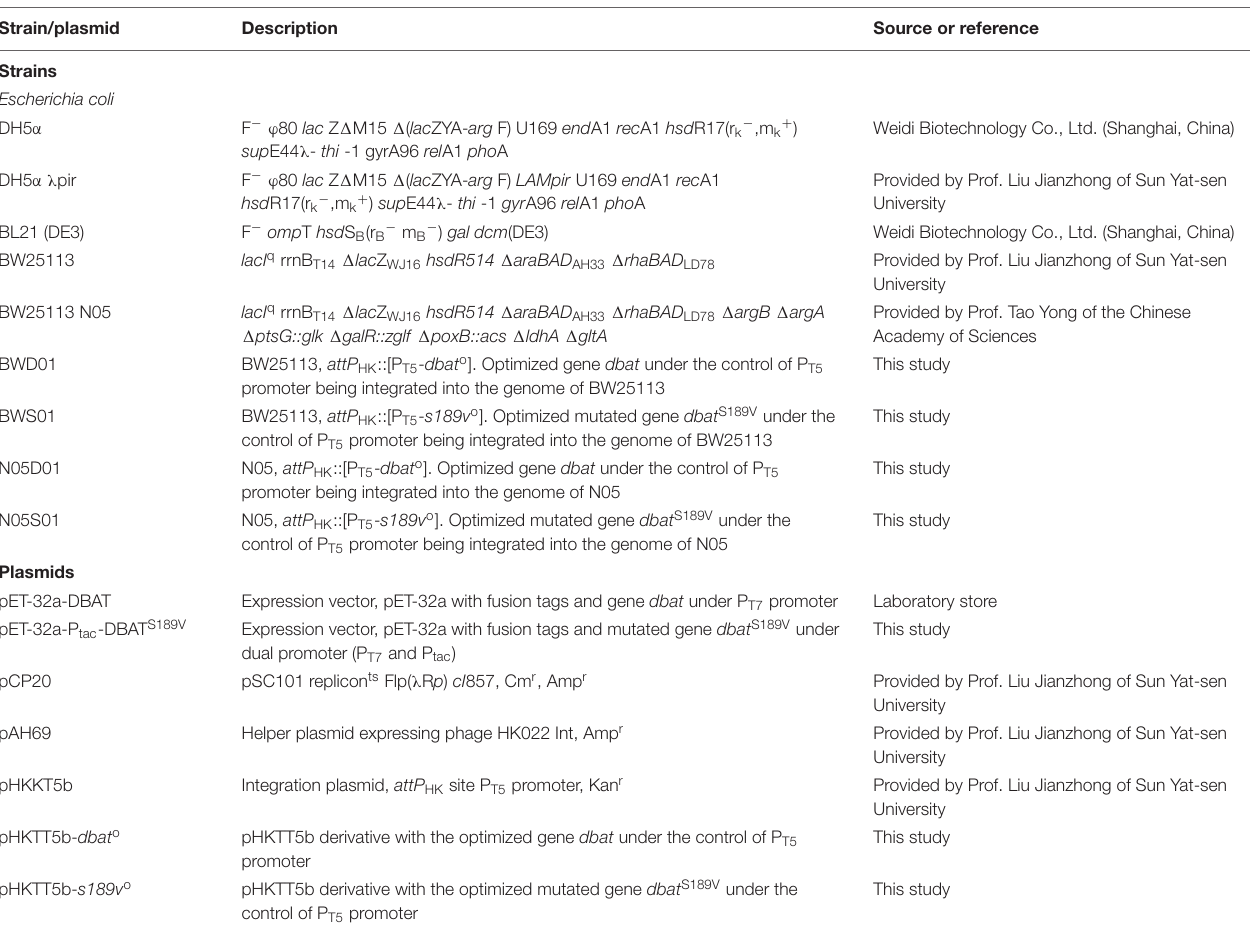
TABLE 1 | Strains and plasmids used in this